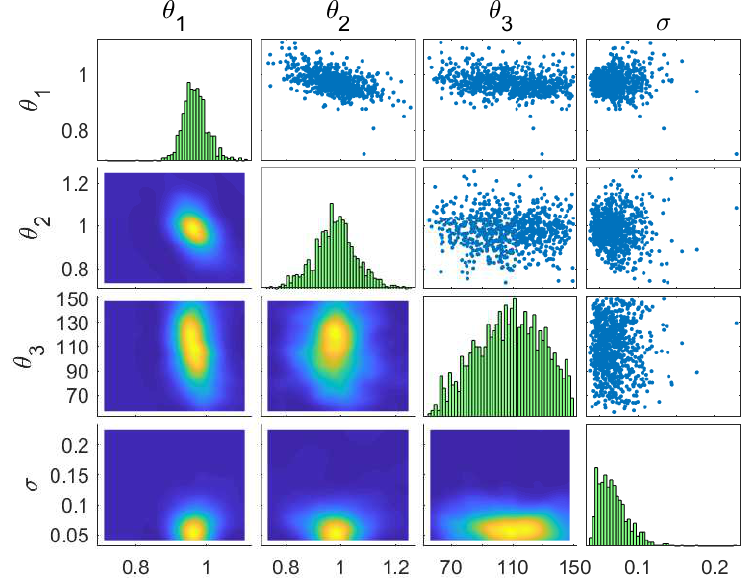
Figure 3. Posterior marginal distributions and 2D sample projections of model parameters. θ 1 : deck, θ 2 : piers, θ 3 : soil, σ : prediction error, log-evidence = 2.527.